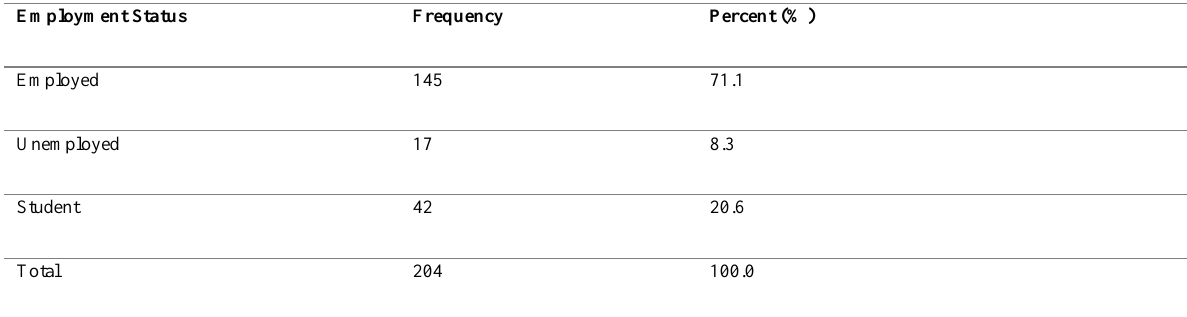
Table 5. Employment Status of Participants after Migrating to Urban Centres